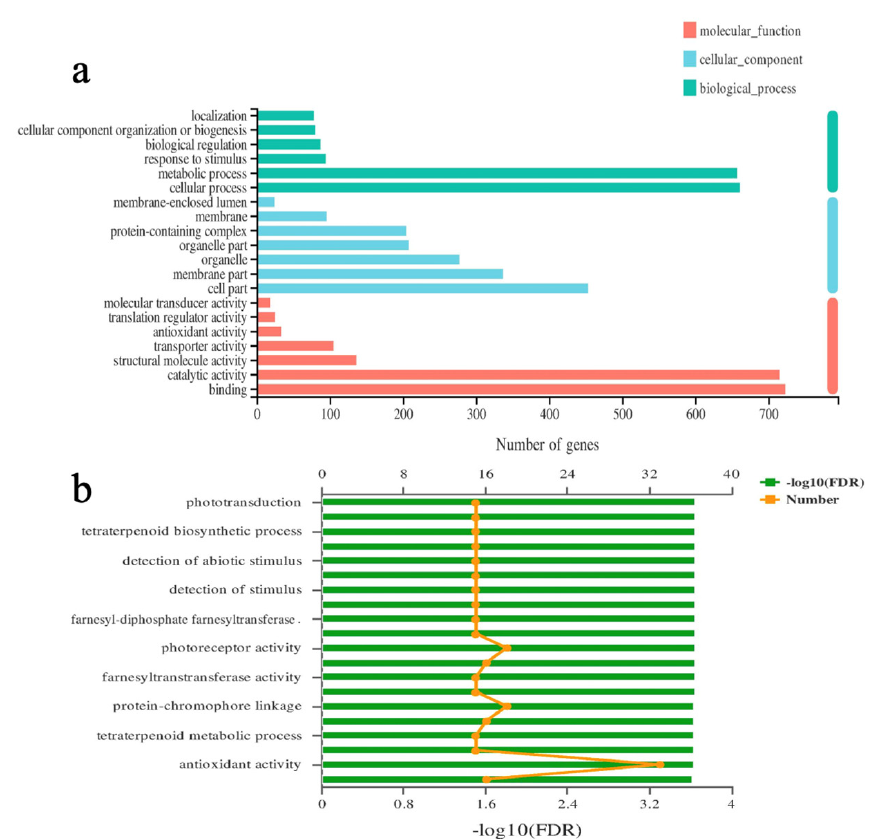
Figure 6. Bubble diagram of GO functional enrichment results of differentially expressed genes in the T9 treatment. ( a ) Significantly enriched the Top 10 GO terms. ( b ) Difference genes with the most significant enrichment degree.